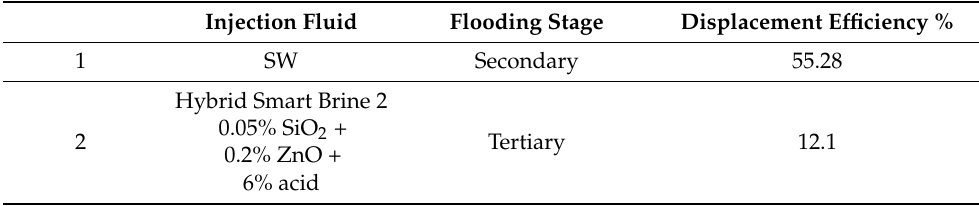
Table 17. Summary of CF10.